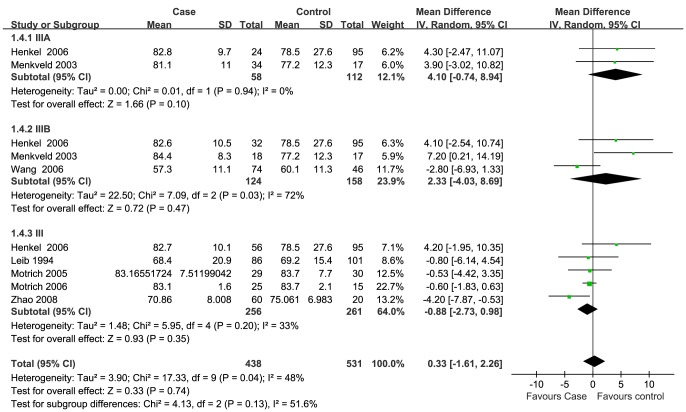
Forest plot showing the meta-analysis outcomes of the effect of CP/CPPS on sperm vitality.